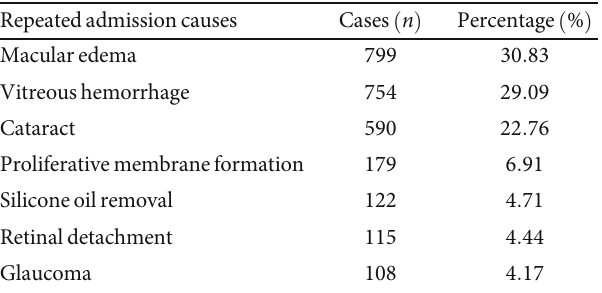
Table 1: Repeated admission causes of diabetic retinopathy